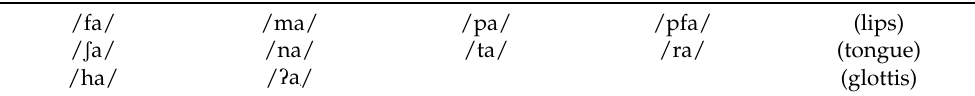
Table 4. Raw scores and standardized scores of the BoDyS scales (median and range) for the CTRL and the PAT groups. Standardized CTRL scores (median = 0, 1%- cutoff = −2.33) are not listed. Table A5. CV syllables (parameter SYLL) . The consonants were evaluated for the accurate realiza- tion of place, manner, voicing, and nasality. /fa/ /ma/ /pa/ / S a/